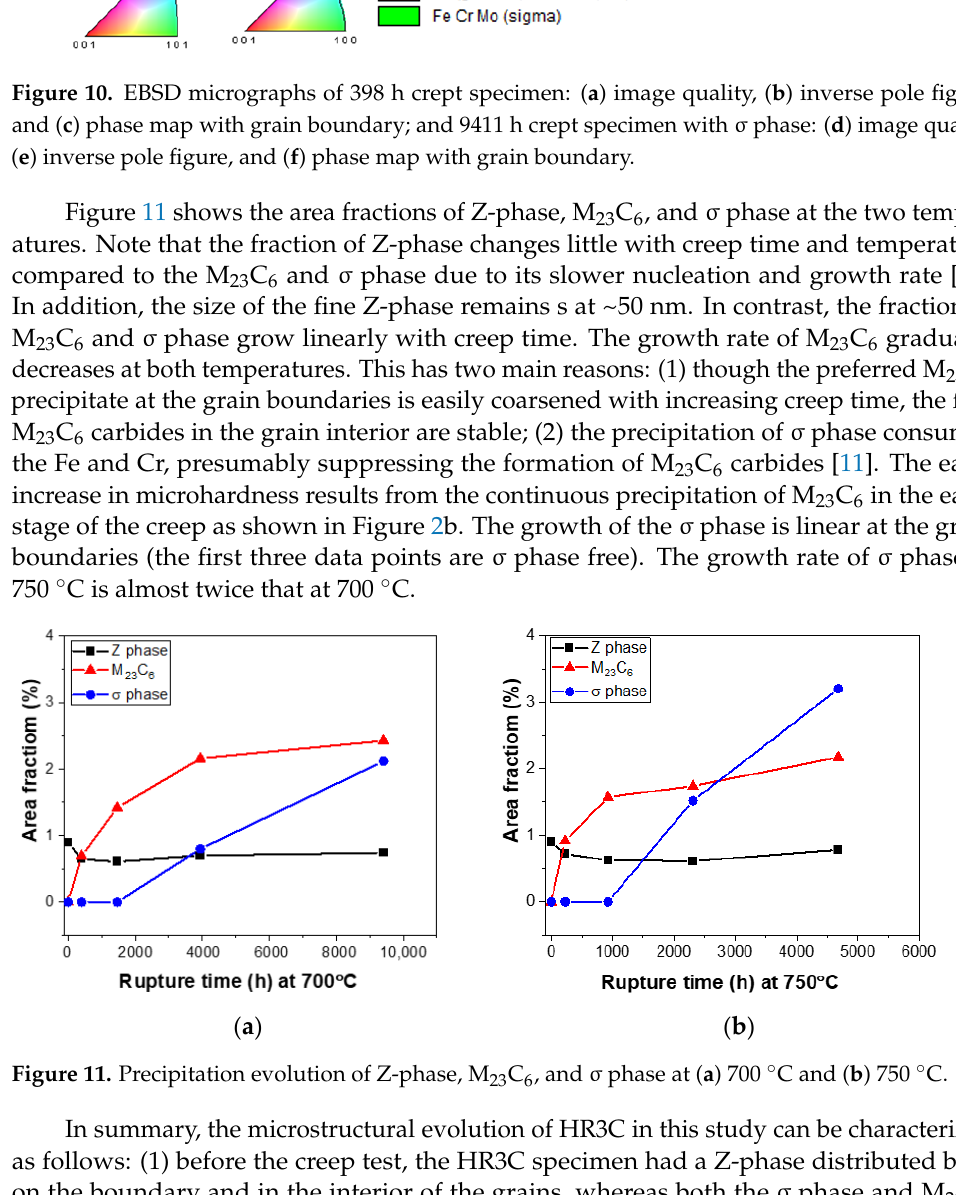
Figure 10. EBSD micrographs of 398 h crept specimen: ( a ) image quality, ( b ) inverse pole figure, and ( c ) phase map with grain boundary; and 9411 h crept specimen with σ phase: ( d ) image quality, ( e ) inverse pole figure, and ( f ) phase map with grain boundary.